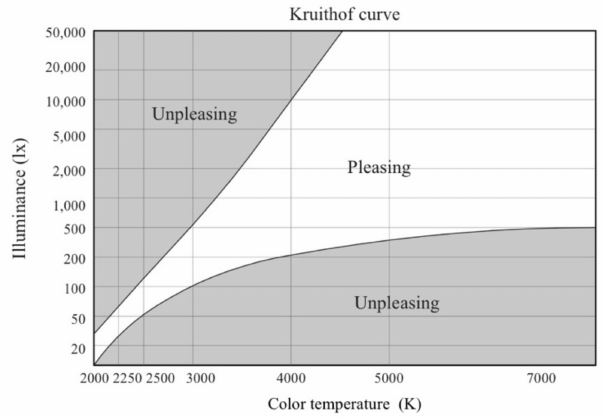
Figure 2. The Kruithof